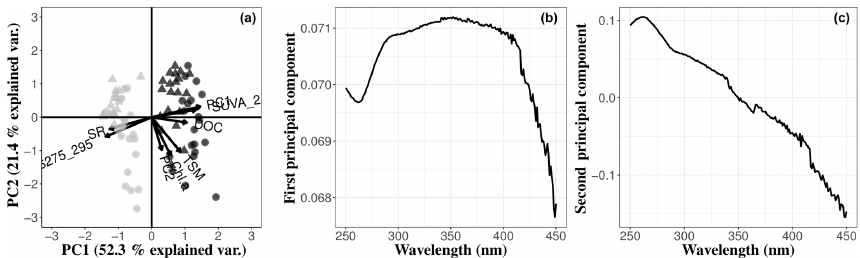
Figure 5. Results of redundancy analysis (RDA) (a) and the first two principal components obtained from PCA, PC1 (b) and PC2 (c) , plotted against wavelengths. Gray symbols represent the treatments without organic matter addition and the black ones those with organic matter. Triangles represent treatments without added nutrients and circles those with nutrients